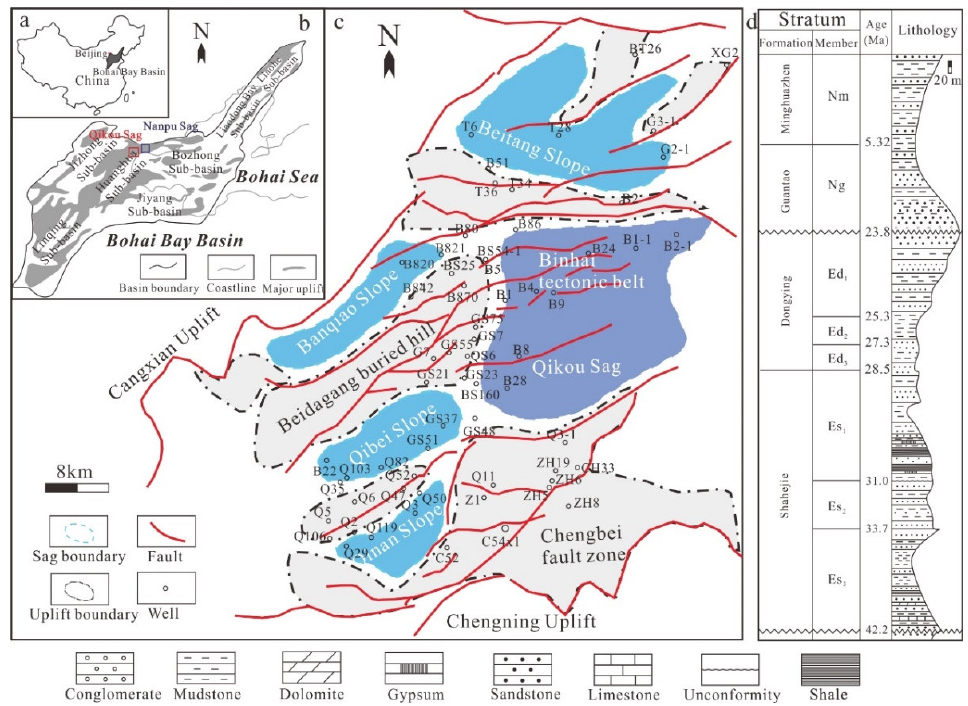
Figure 1. Location and geological features of the Qikou Sag, Bohai Basin (Modified from [21]). ( a ) location the Bohai Bay Basin; ( b ) locations and distribution of sub-basins in the Bohai Bay Basin; ( c ) geological map of of structural belts in the Qikou Sag; ( d ) lithostratigraphic section of the Qikou Sag.